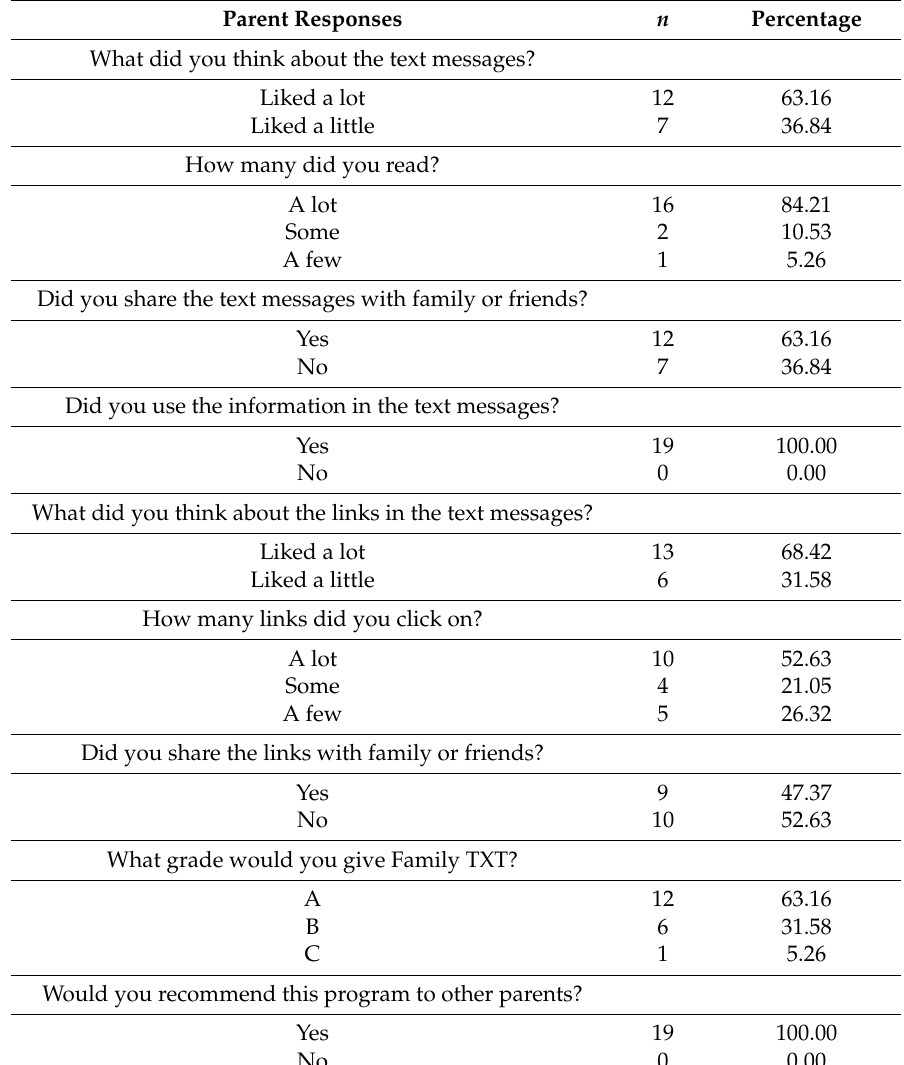
Table 2. Reactions to text messages ( n =